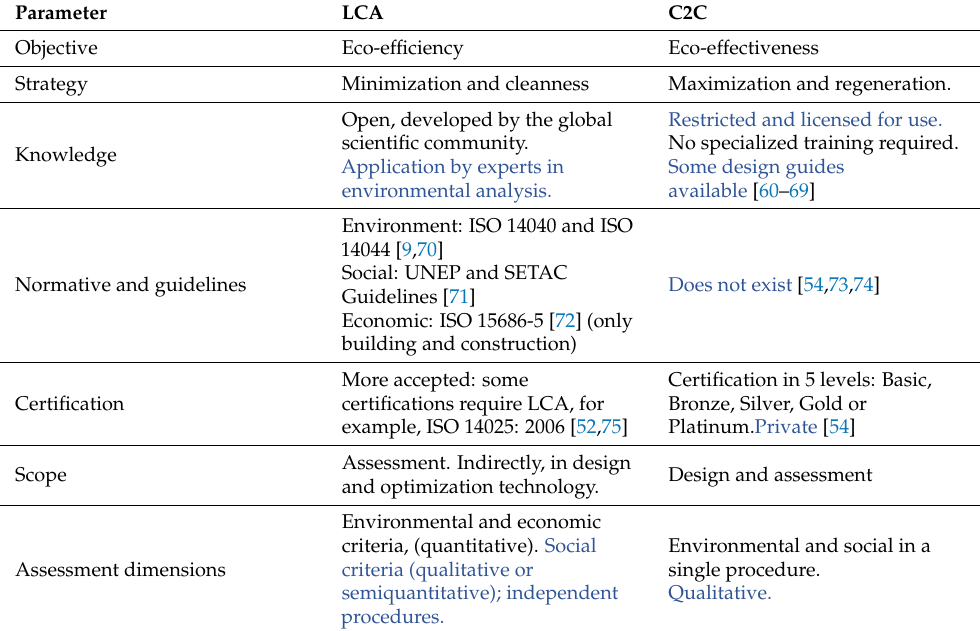
Table 1. Comparison of LCA and C2C (advantages in black; disadvantages in